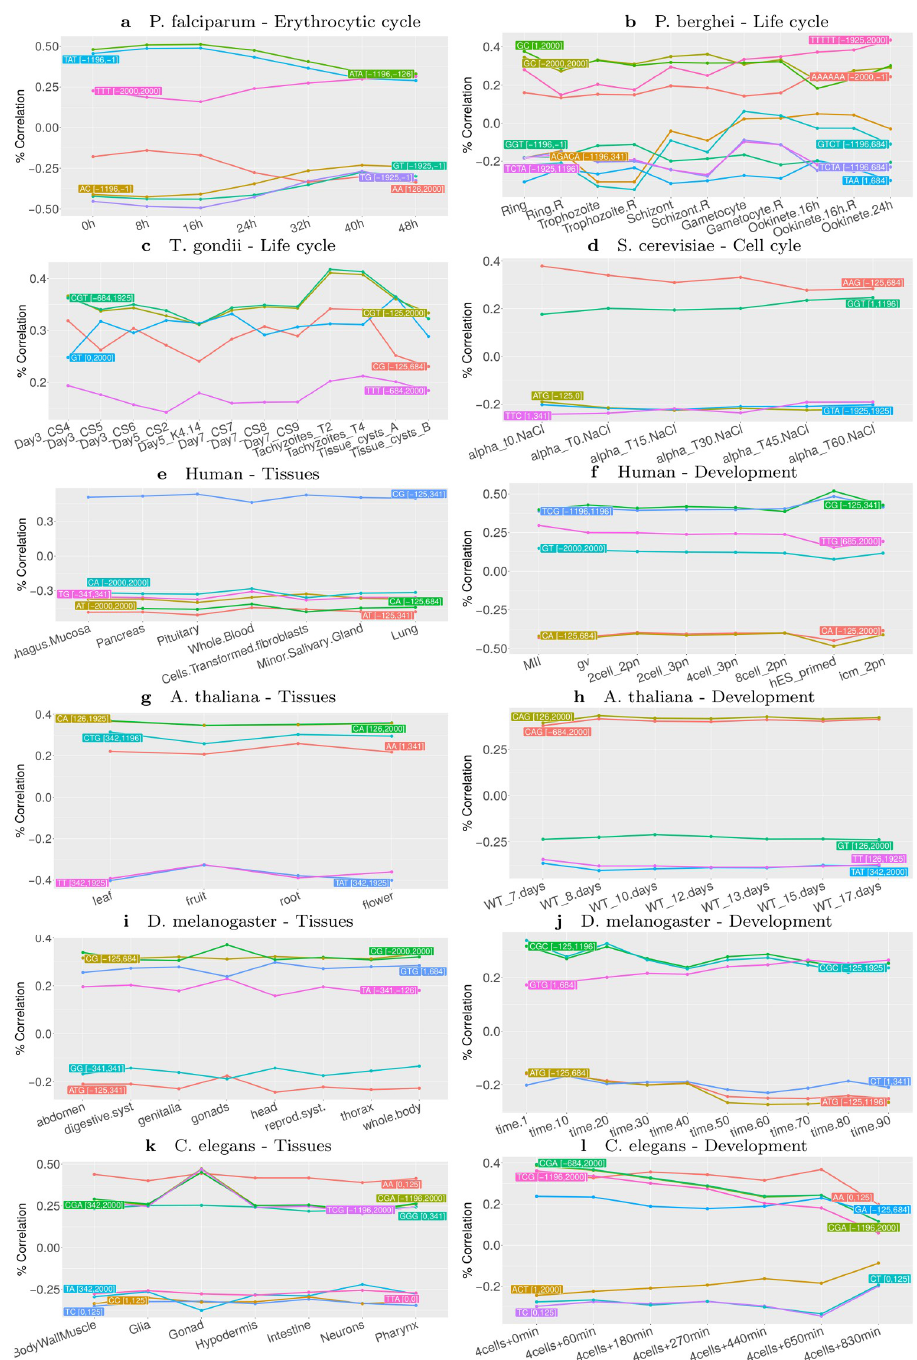
Fig 4. Correlations between expression and k-mer frequency of the most important variables identified in the different species and conditions. For each expression series, the 5 most important variables of each condition were identified, and their correlation to expression were computed for all conditions of the series. The name of the variables has been shortened for readability: for example the variable ATA [-1196,-126] is actually the frequency of k-mer ATA in region [-1196,-126]. Note that there are often more than 5 variables in these figures because the 5 most important variables may vary depending on conditions.